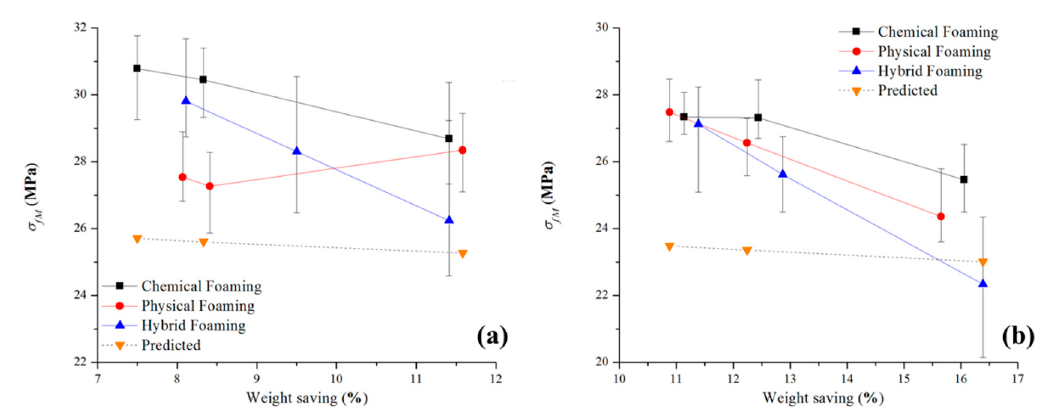
Figure 9. Maximum Flexural Strength ( σ fM ) against weight-saving ( a ) unfilled PP ( b ) talc-filled PP.